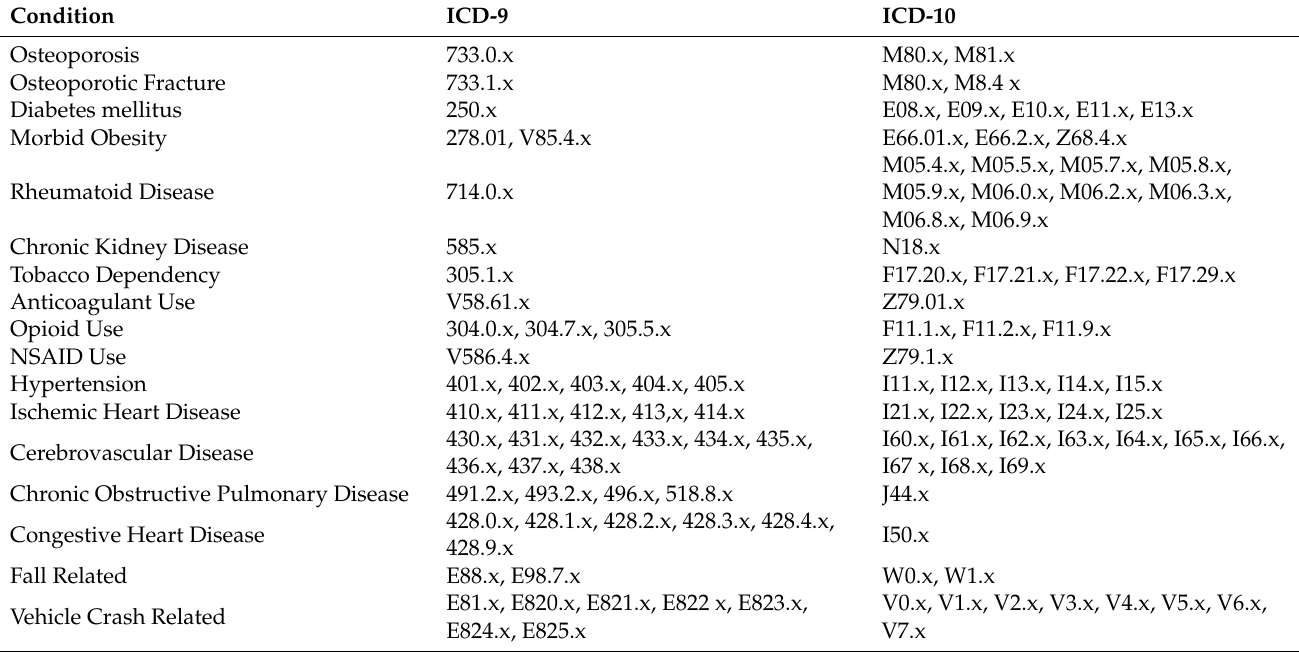
Table A1. Clinical indicator